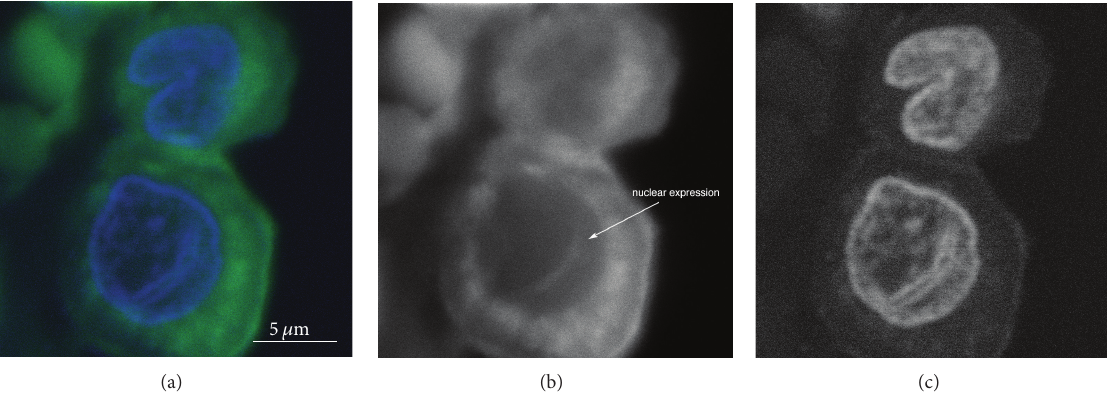
Figure 3: Confocal fluorescence microscopy of cells located in the cambium layer and stained for Cbfa-1/Runx2. (a) Merged fluorescence image showing in blue the nuclear DAPI stain and in green the staining for Cbfa-1/Runx2. (b) Cbfa-1/Runx2 staining in black and white, note the nuclear expression pattern (arrow) in addition to the distinct cytoplasmic expression pattern. (c) Nuclear stain only in black and